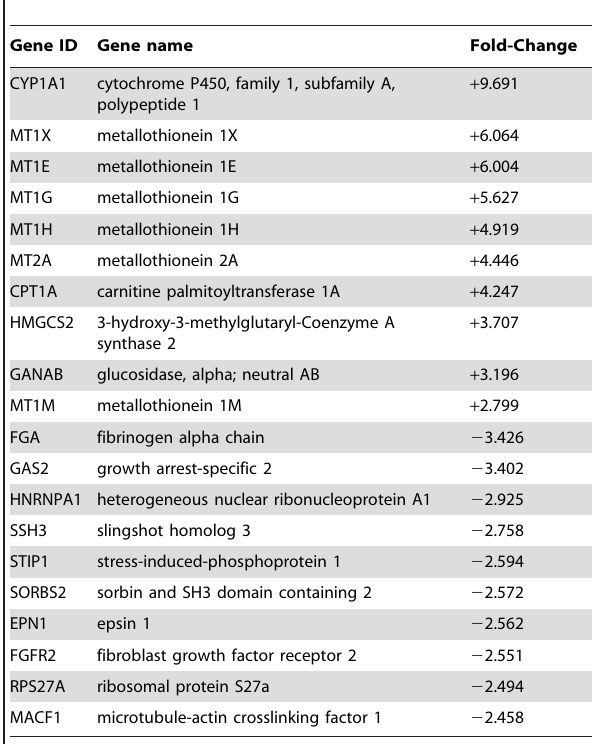
Table 2. The top ten genes modulated by